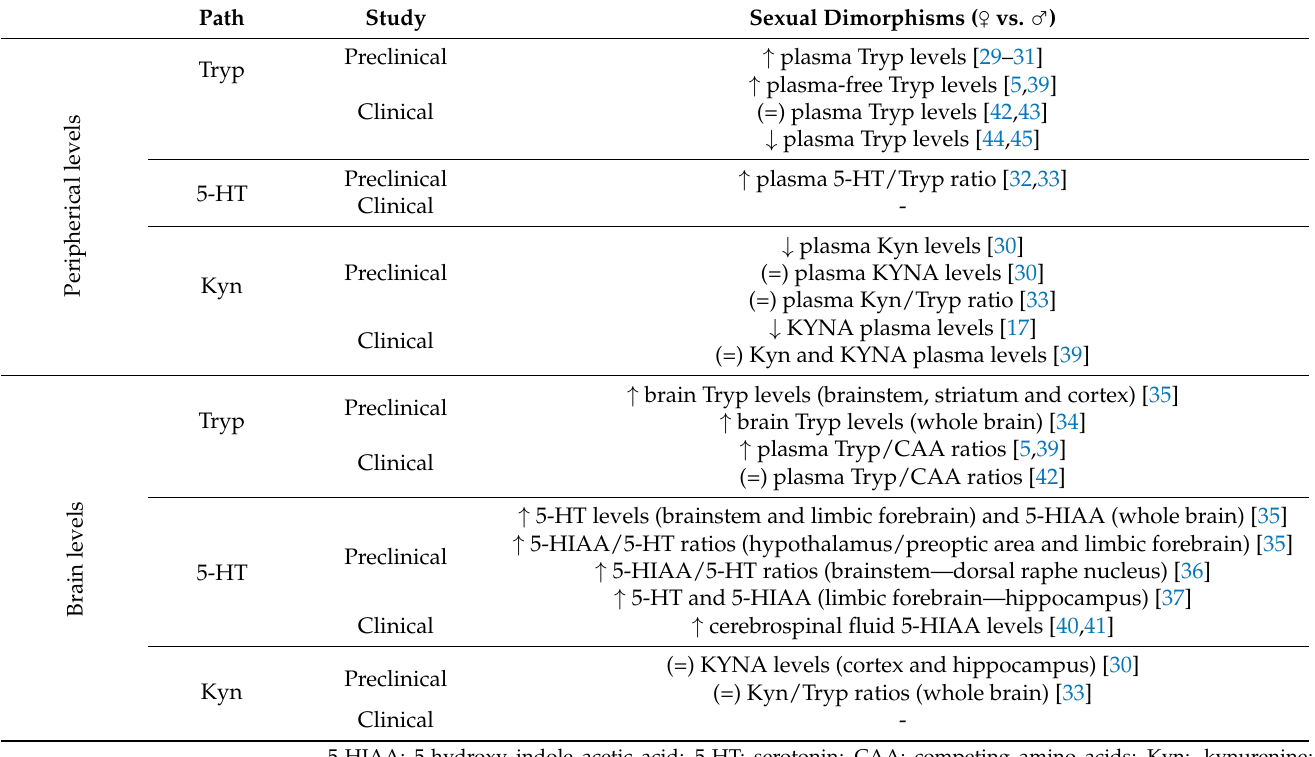
Table 1. Highlights of differences in tryptophan metabolism between sexes: healthy